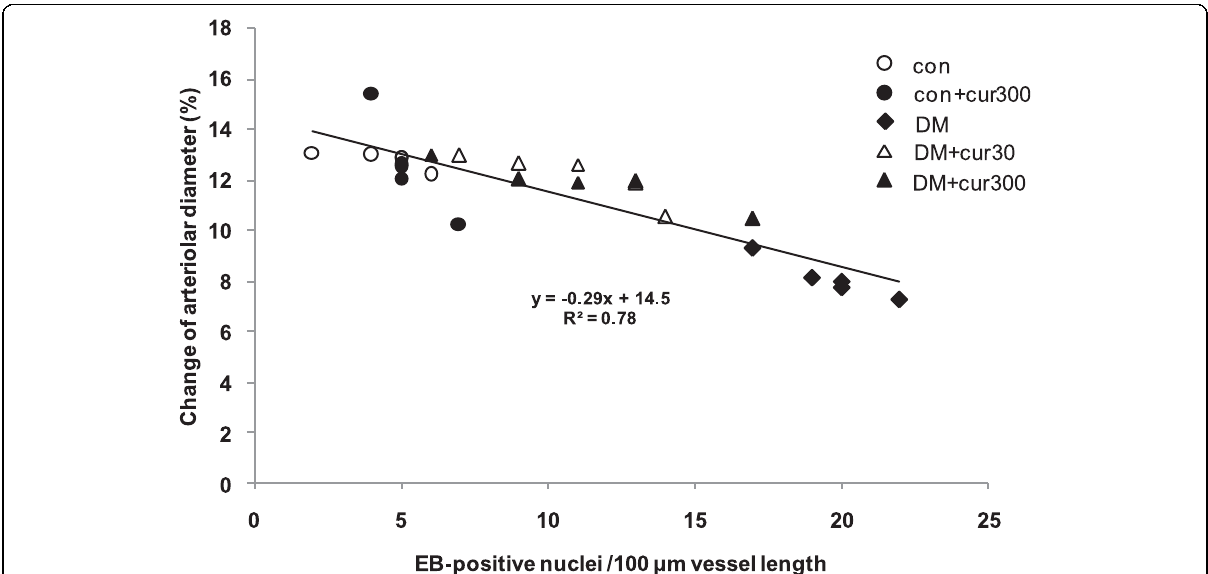
Figure 6 Relationship between ethidium bromide-positive nuclei and % changes in ACh-induced arteriolar vasodilation . Relationship between EB-positive nuclei per 100 μ m vessel length and percentage of ACh-induced change in arteriolar diameter for diabetes (DM), diabetes treated with 30 and 300 mg/kg curcumin (DM+cur30 and DM+cur300, respectively), control (con) and control treated with 300 mg/kg curcumin